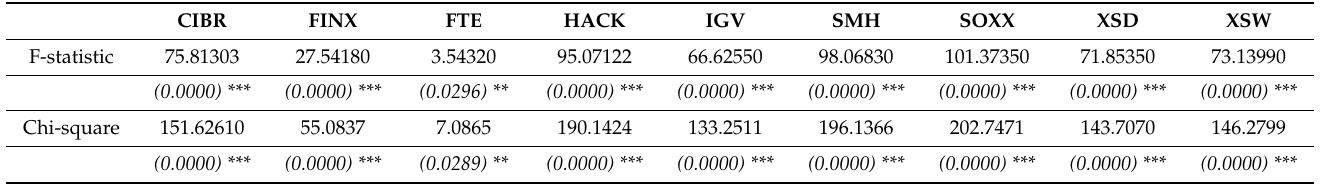
Table A6. WALD Test for idiosyncratic risk coefficient combined.